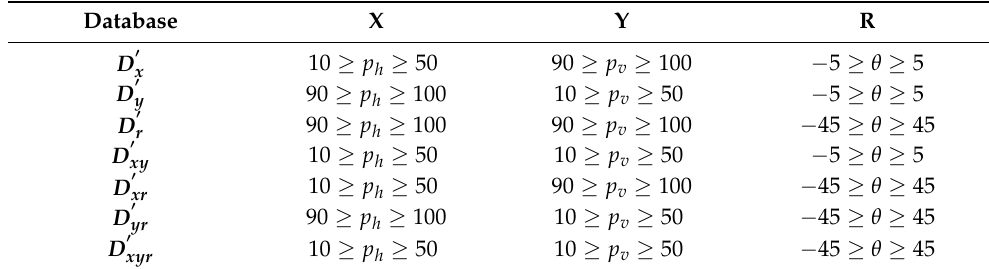
Table 1. Parameters considered for the creation of the various artificial databases. X represents the range of factors for the vertical stretch, Y represents the range of factors for the horizontal stretch, and R represents the range of factors for the rotation. Each database contained 20 artificial datasets. Each dataset contained 60 matrices for each label, thus 360 matrices in